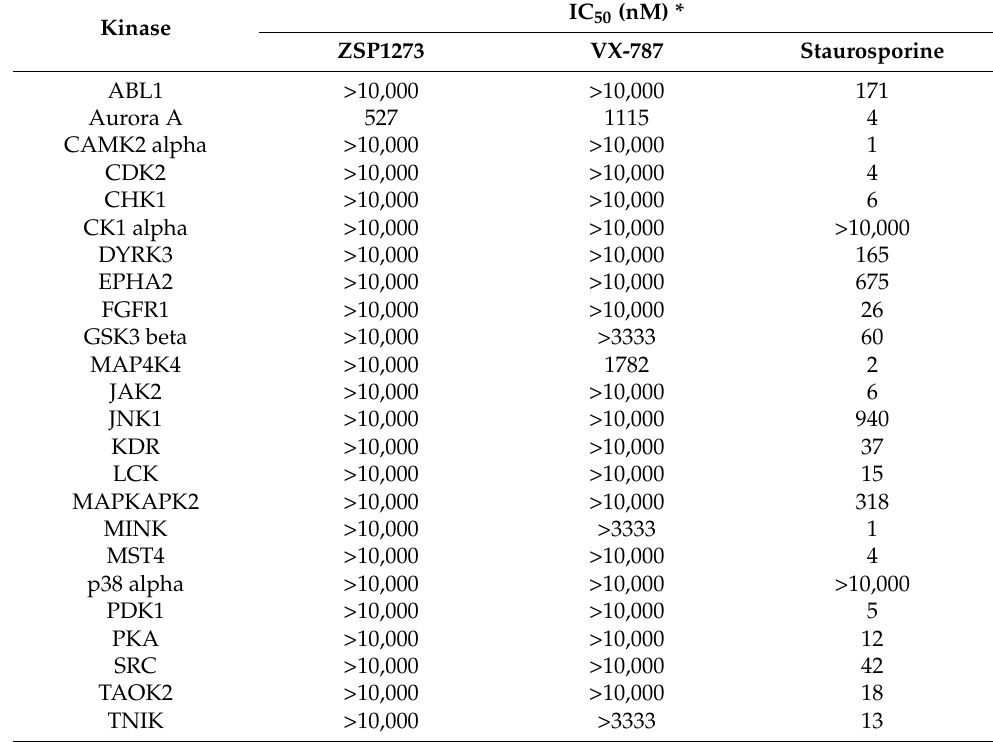
Table A2. Summary of the IC 50 of ZSP1273 against 24 kinases by kinase profiling.